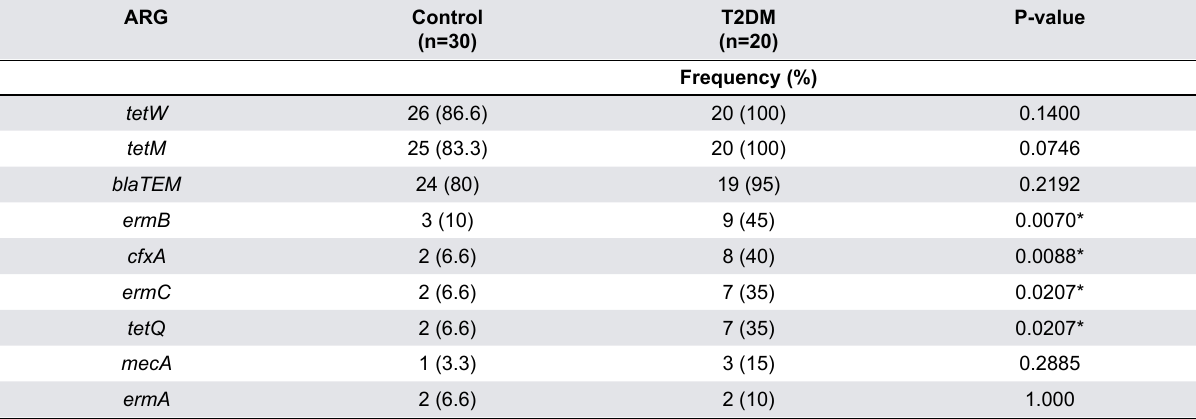
Table 3- Distribution of the nine antimicrobial resistance genes (ARGs) in both groups